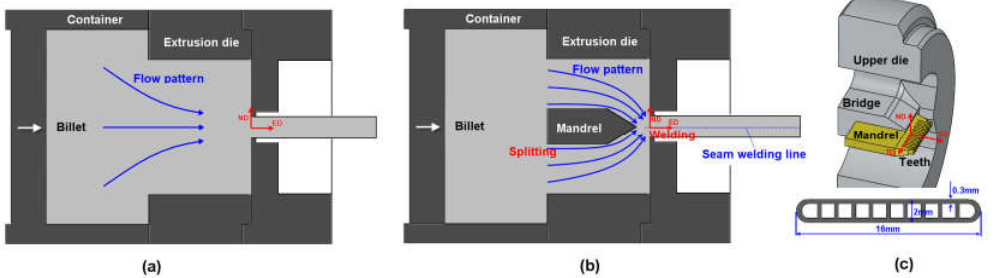
Figure 1. Schematic representations of ( a ) the regular die, ( b ) the porthole die, and ( c ) the mandrel structure and tube section.